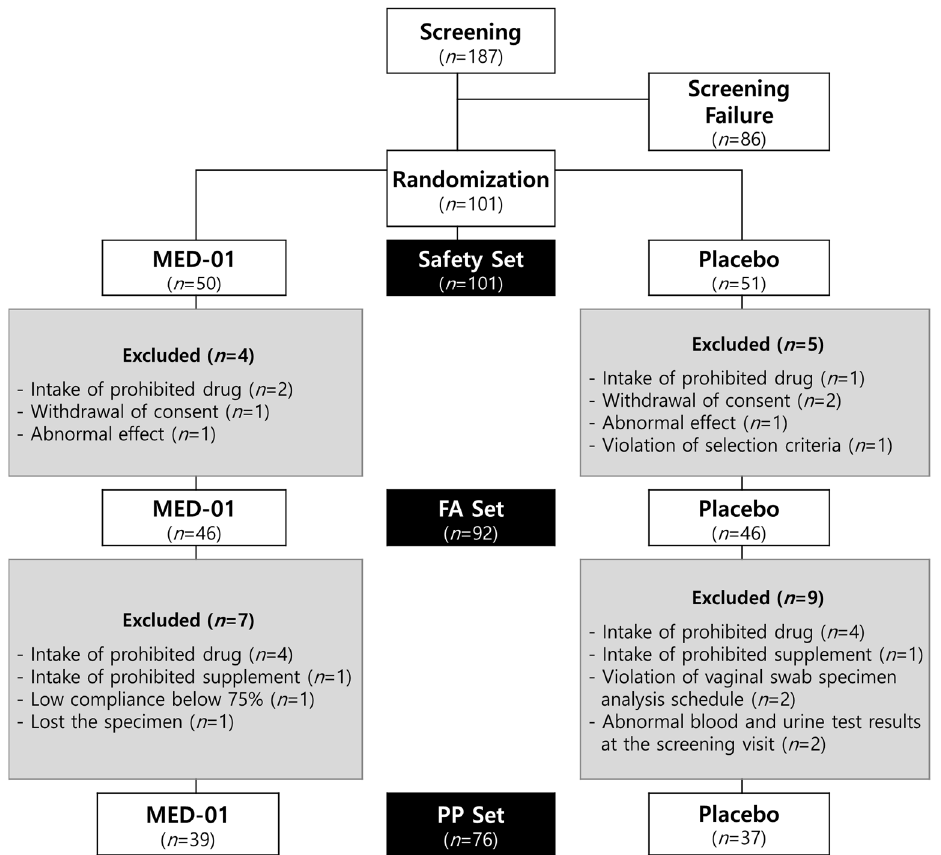
Figure 1. Flow diagram illustrating the selection of participants.